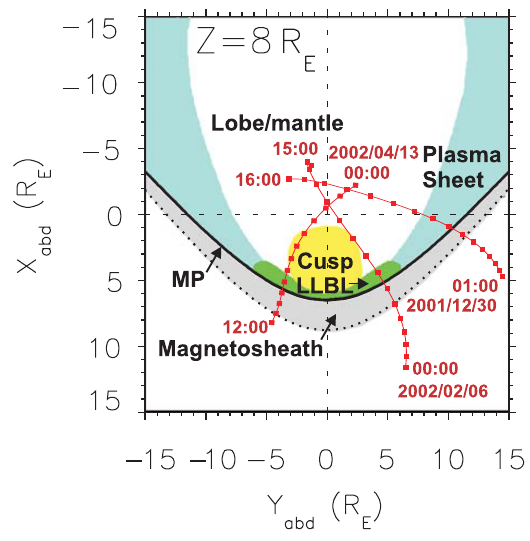
Fig. 1. Examples of trajectories (red curves with points separated by one-hour intervals) of Cluster in the aberrated-displaced X − Y plane at | z | =8 R E . The three examples correspond to the individual events which are discussed in Sect. 3. The magnetopause location is inferred from the model of Shue et al. (1997), using a mean solar wind pressure of 2nPa and a southward component of the interplan- etary magnetic field set to 0.